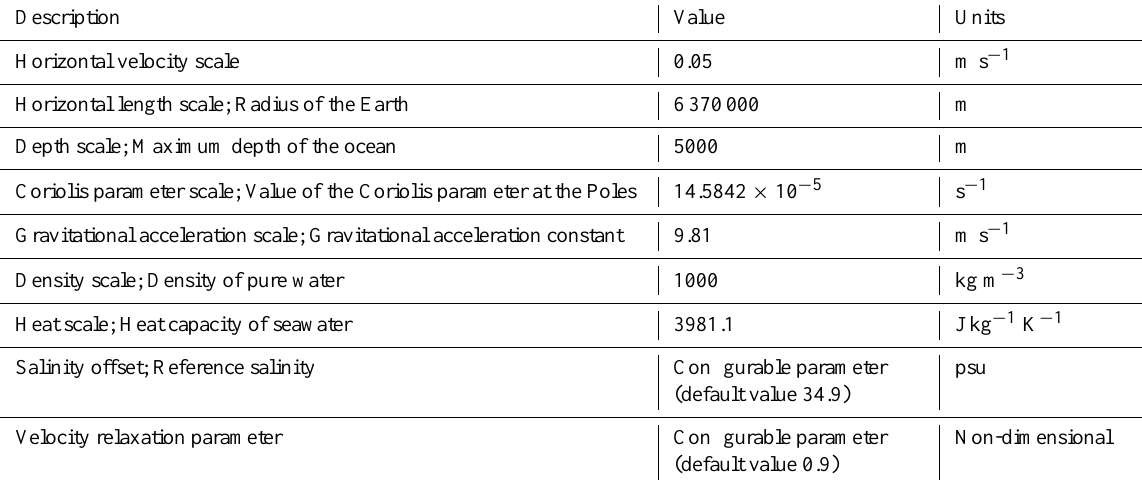
Table A1. : Dimensional scale values, constants, parameters, and offsets used by the GOLDSTEIN ocean model component, from some of which further scale values are derived (see also Edwards et al., 1998; Edwards and Shepherd, 2001.)